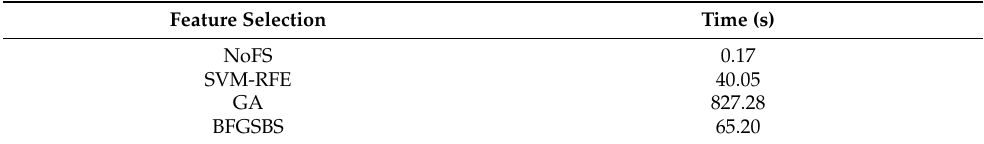
Table 14. Runtime of different feature selection algorithms.